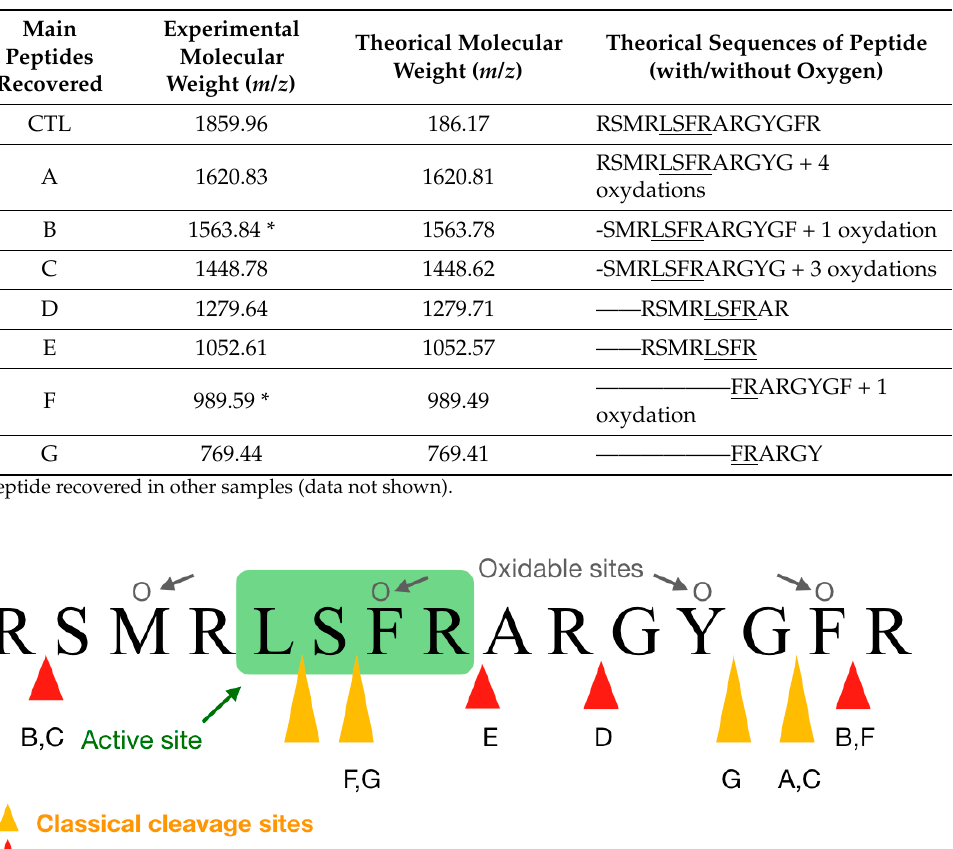
Table 1. Molecular weight as determined by MALDI-TOF mass spectrometry and sequence of the recovered peptides.